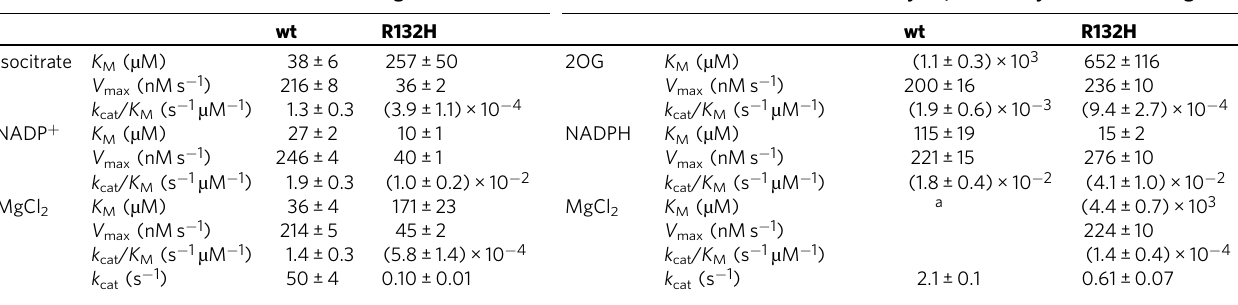
Table 1 Effects of magnesium and manganese ions on kinetic parameters for the oxidative and reductive reactions of wt and R132H IDH1, respectively. Oxidative reaction (isocitrate to 2OG) with Mg 2